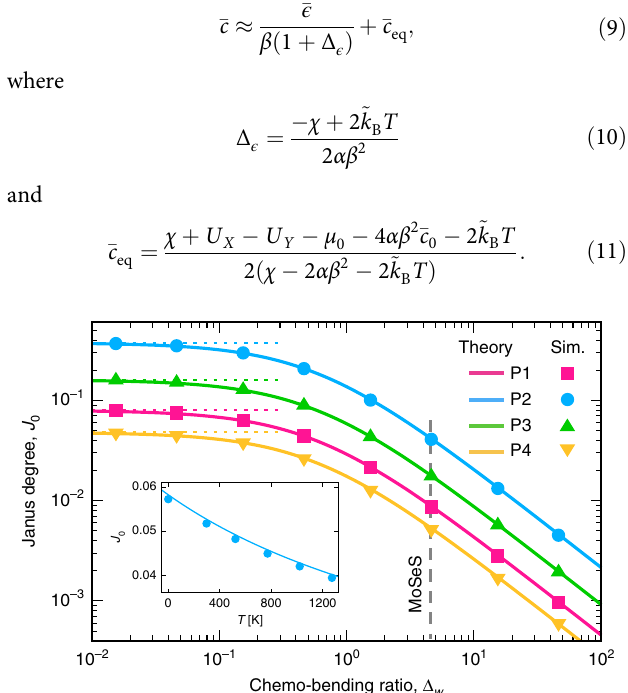
Fig. 3 Effect of compositional thermodynamics on shape ! composition programming. Simulation results validating analytic predictions for bending- dominated monolayers are also shown. Solid and dashed lines are the expressions in the second column (Composition J ) of Table 1 and the F c ¼ 0 limit ( Δ w ! 0), respectively, and points are simulation results ± obtained at equal Se and S concentrations ( (cid:1) c ¼ 1 = 2). J Inset: J 0 vs. T for P2 (a 1D